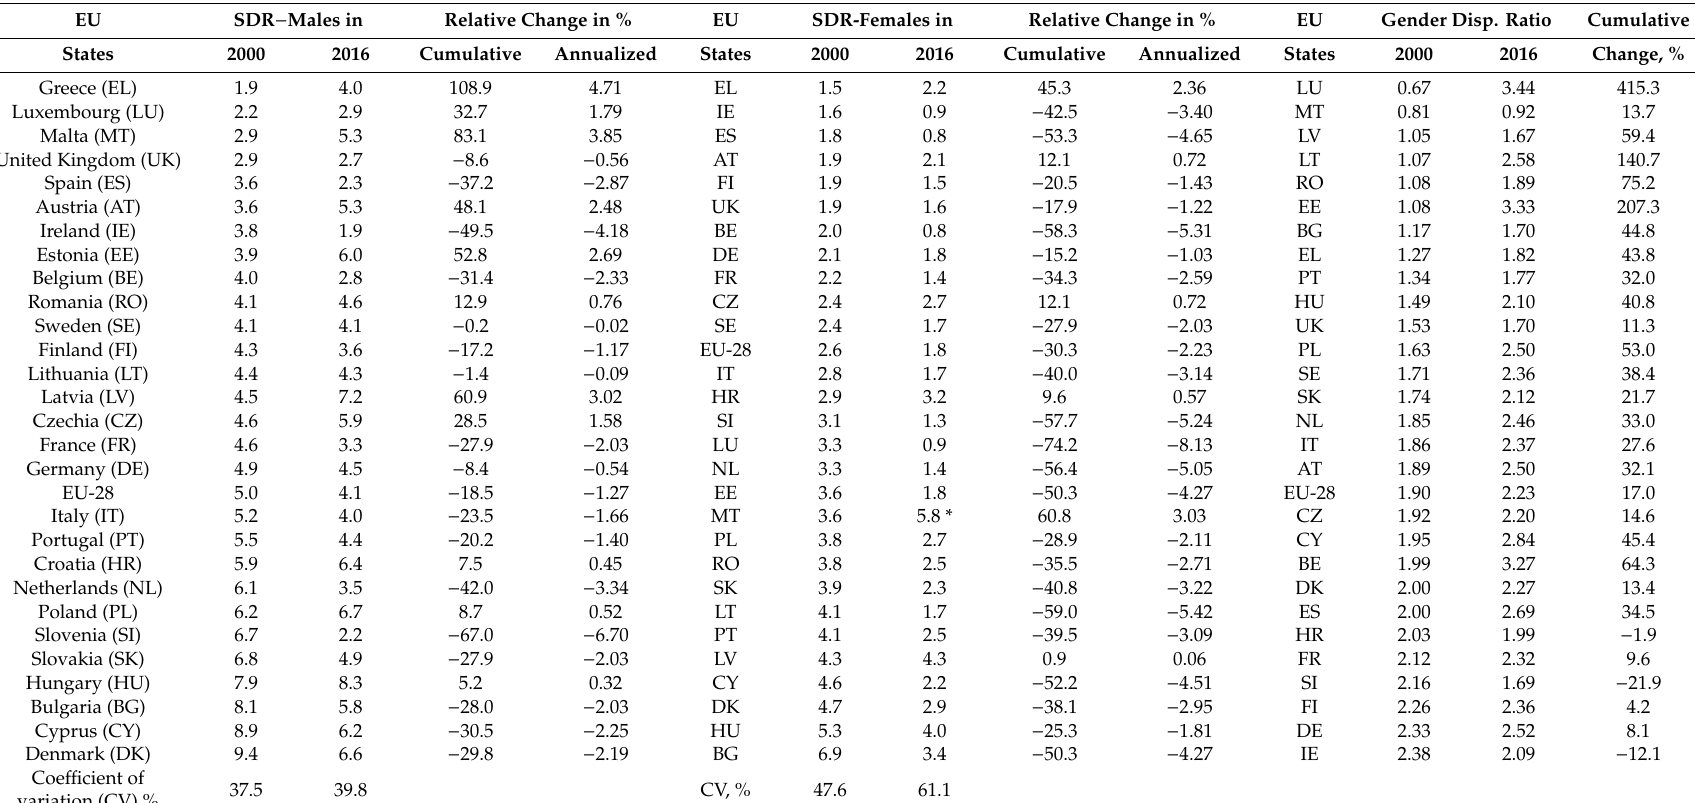
Table 6. Premature SDR for diabetes mellitus in the EU countries in 2000 and 2016 1